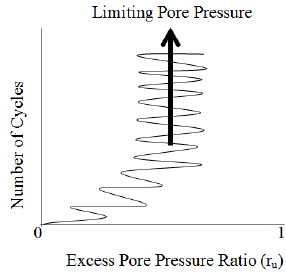
Figure 10. Limiting pore water pressure in a simple shear test (Reprinted from [37]).